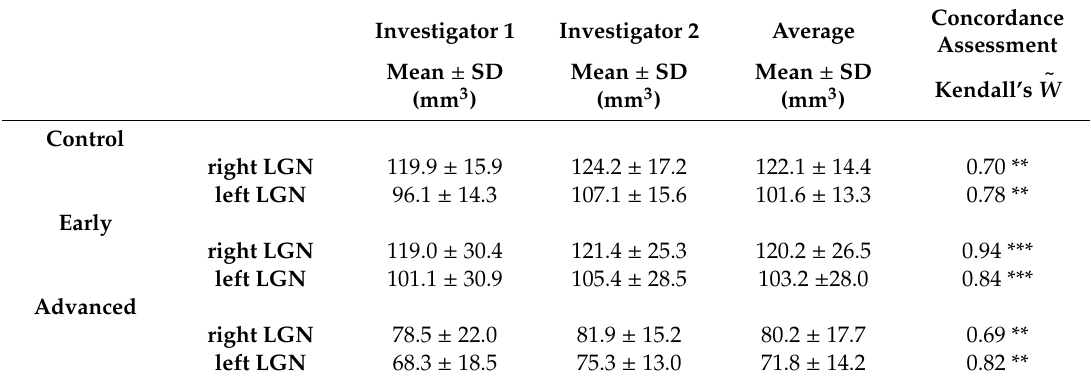
Table 3. LGNs volume evaluation performed by two blinded and independent investigators (two